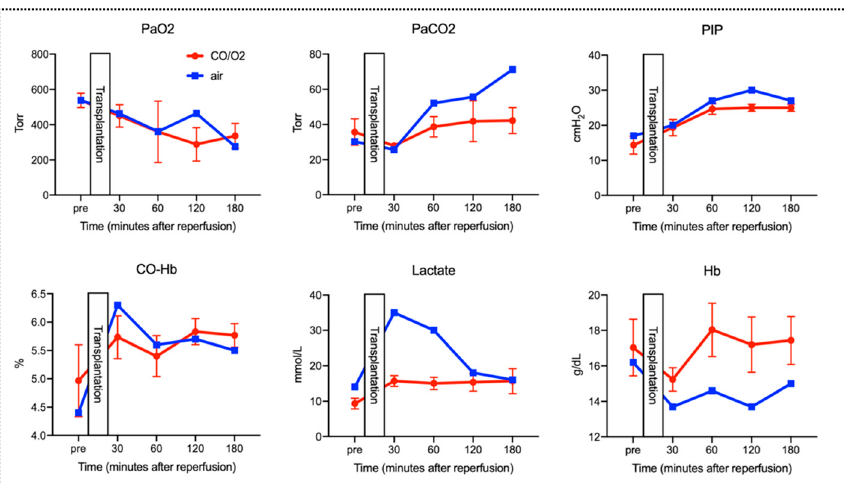
Figure 6. Assessment of chorological changes in parameters of arterial blood gases (ABG). The red line shows parameters in the CO/O 2 group, and the blue line shows parameters in the air group. Each data of red lines are expressed as the means ± standard deviations.